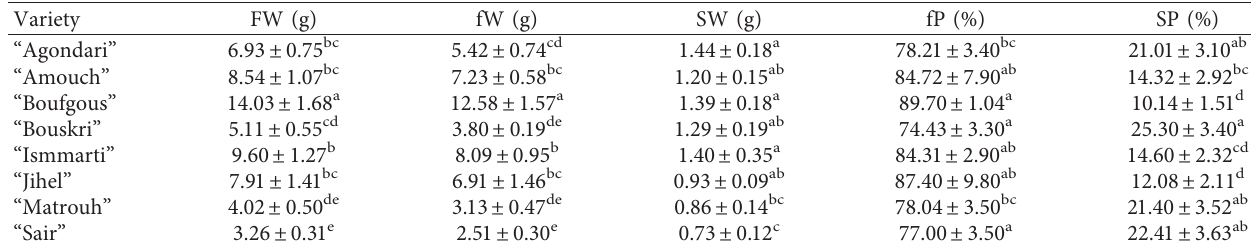
Table 1: Mean values of physical fruits traits, namely, fruit weight (FW), flesh weight (fW), seed weight (SW), flesh percent (fP), and seed percent (SP), for the studied date palm varieties. All values are means ± standard deviation. In each column, values followed by the same letter are not significantly different at 5% as a probability